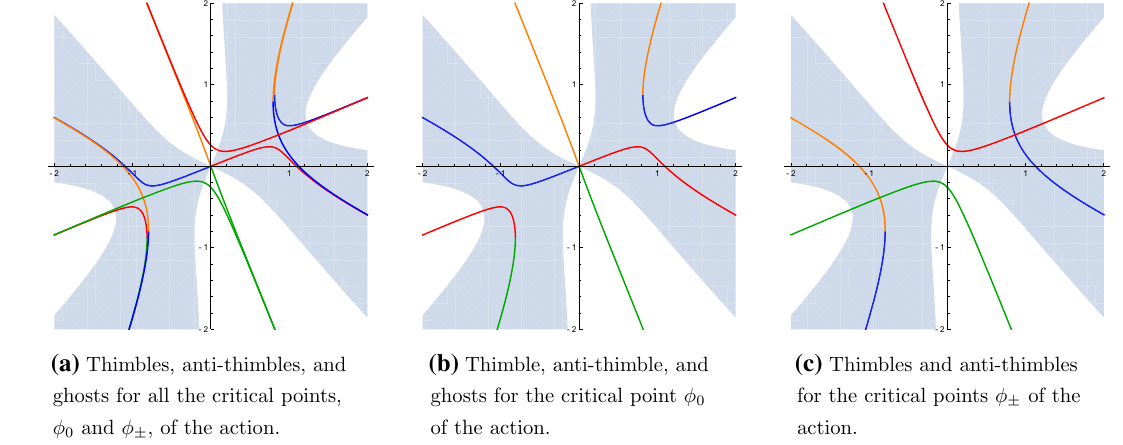
Fig. 4 Demonstration of the piecewise behavior by the solutions to the thimble equation given in Eq. (3.3), corresponding to the critical points φ 0 and φ ± of the action, for the parameters { a = 1, b = − 0 . 9, c = 0, d = 1 . 5, h = 0 } . In all the three figures, the blue solid curves